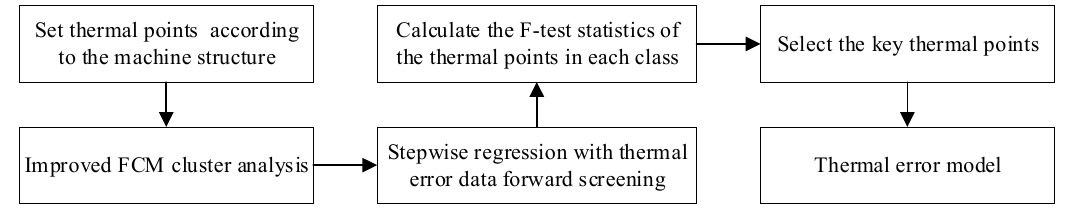
Figure 2. The process of FCM screening temperature points was improved.